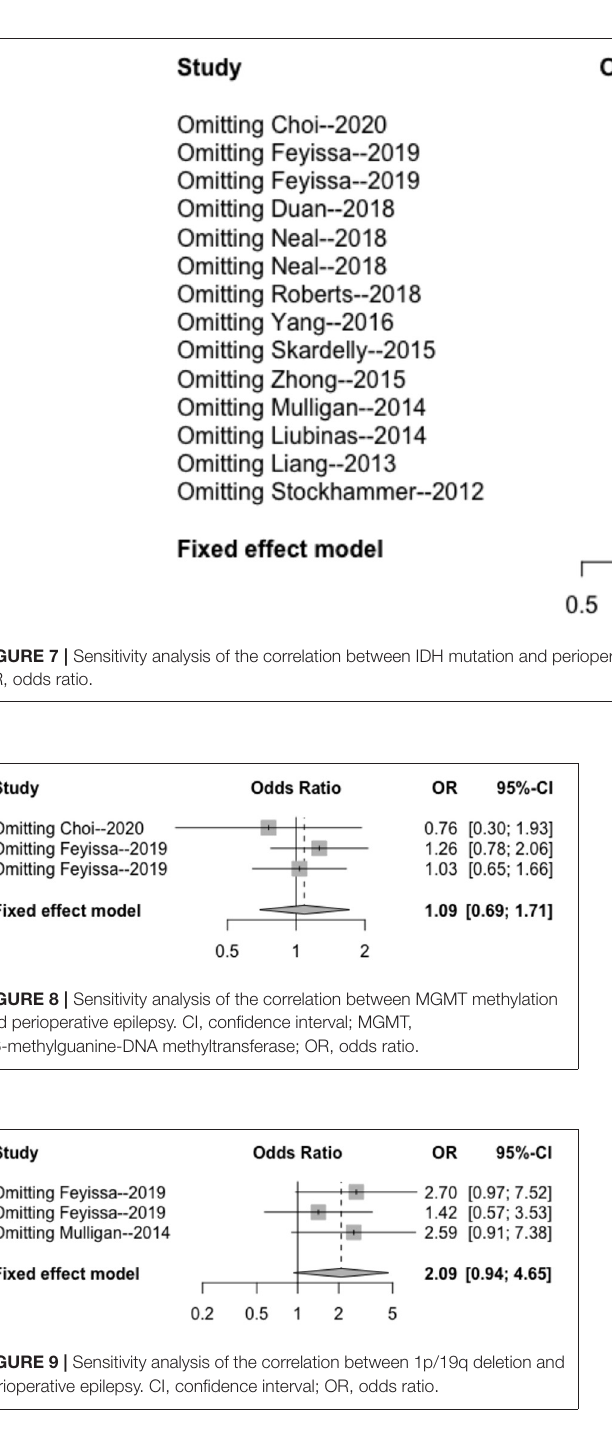
presence of IDH in patients with glioma ( Figure 5 ). The heterogeneity within the preoperative group ( I 2 = 0 < 50%, p = 0.51 > 0.1) and combined effects size (OR = 3.32; 95% Cl: 2.53– 4.36) indicated a significant correlation between the occurrence of preoperative epilepsy and IDH in patients with glioma. The heterogeneity within the postoperative group ( I 2 = 61 > 50%;